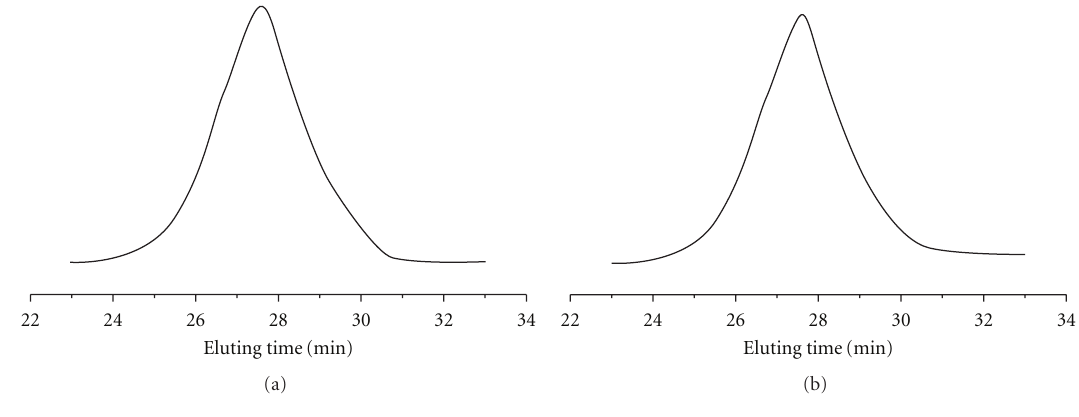
Figure 4: GPC curves of BocNH-PLLA (a) and NH 2 -PLLA (b).